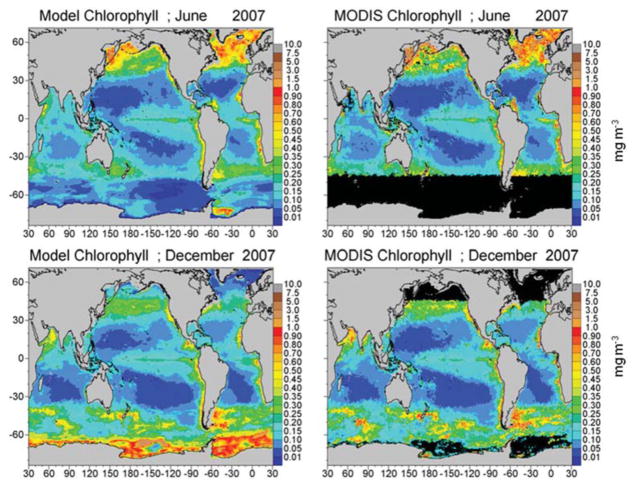
Model assimilated total chlorophyll for June and December 2007 compared to MODIS-Aqua chlorophyll.